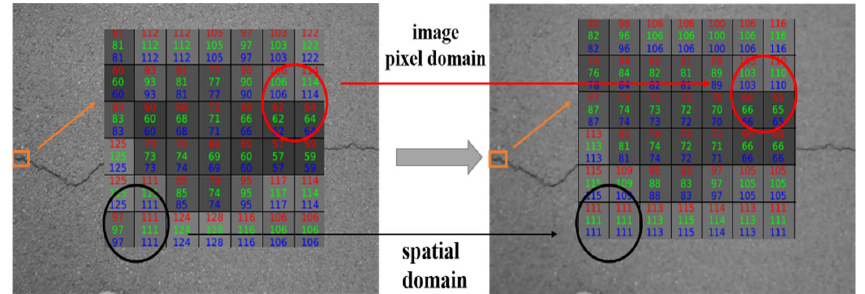
Figure 4. Schematic of the 3rd algorithm.